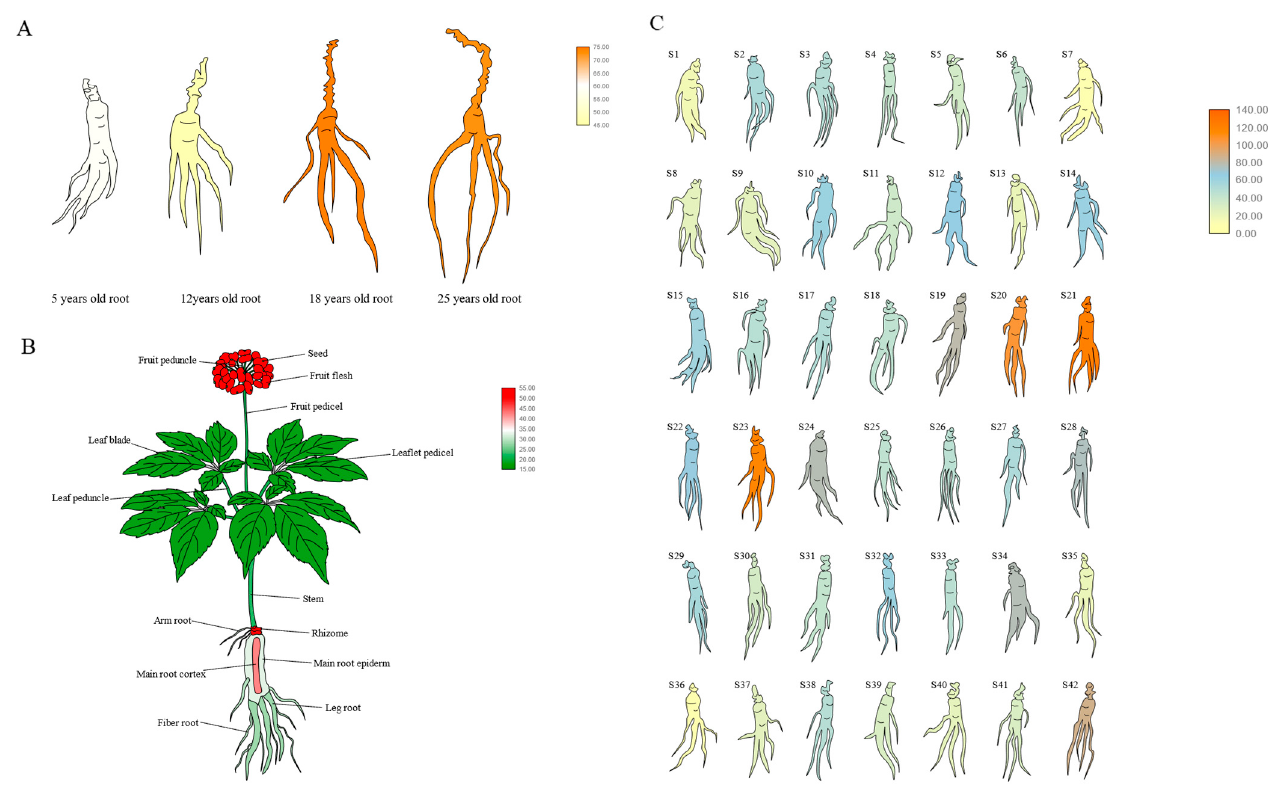
Figure 6. Heatmaps analysis spatiotemporal expression patterns of PgGRAS68-01 gene in Panax ginseng . ( A ) The PgGRAS68-01 gene expressed in the 4 different aged stages (5, 12, 18, 25 years-old) of ginseng roots. ( B ) The PgGRAS68-01 gene expressed in the 14 different tissues of 4-year-old ginseng. ( C ) The PgGRAS68-01 gene expressed in the 42 farmer’s cultivars of 4-year-old ginseng roots.